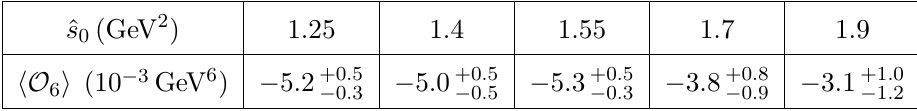
Table 2 . Results for hO 6 i , obtained with our tuple procedure with different values of ˆ s 0